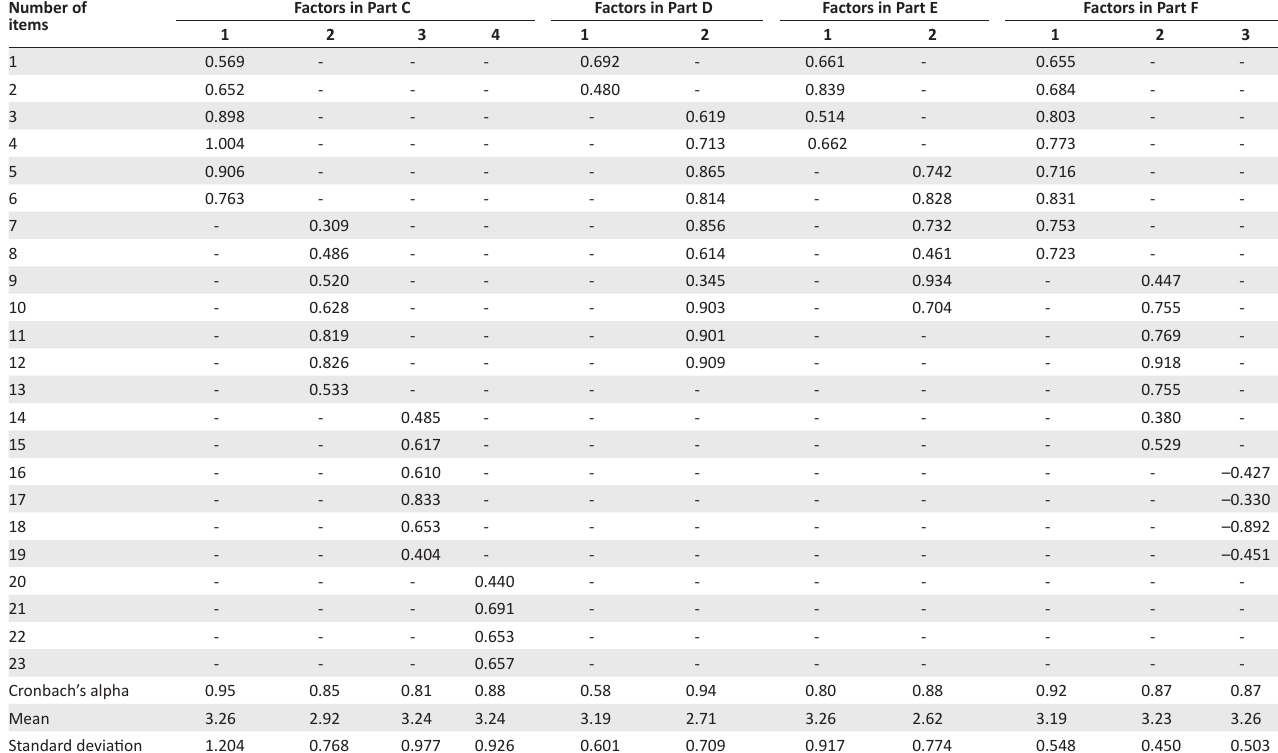
TABLE 7: Pattern matrix of factor analysis for Parts C–F. Number of